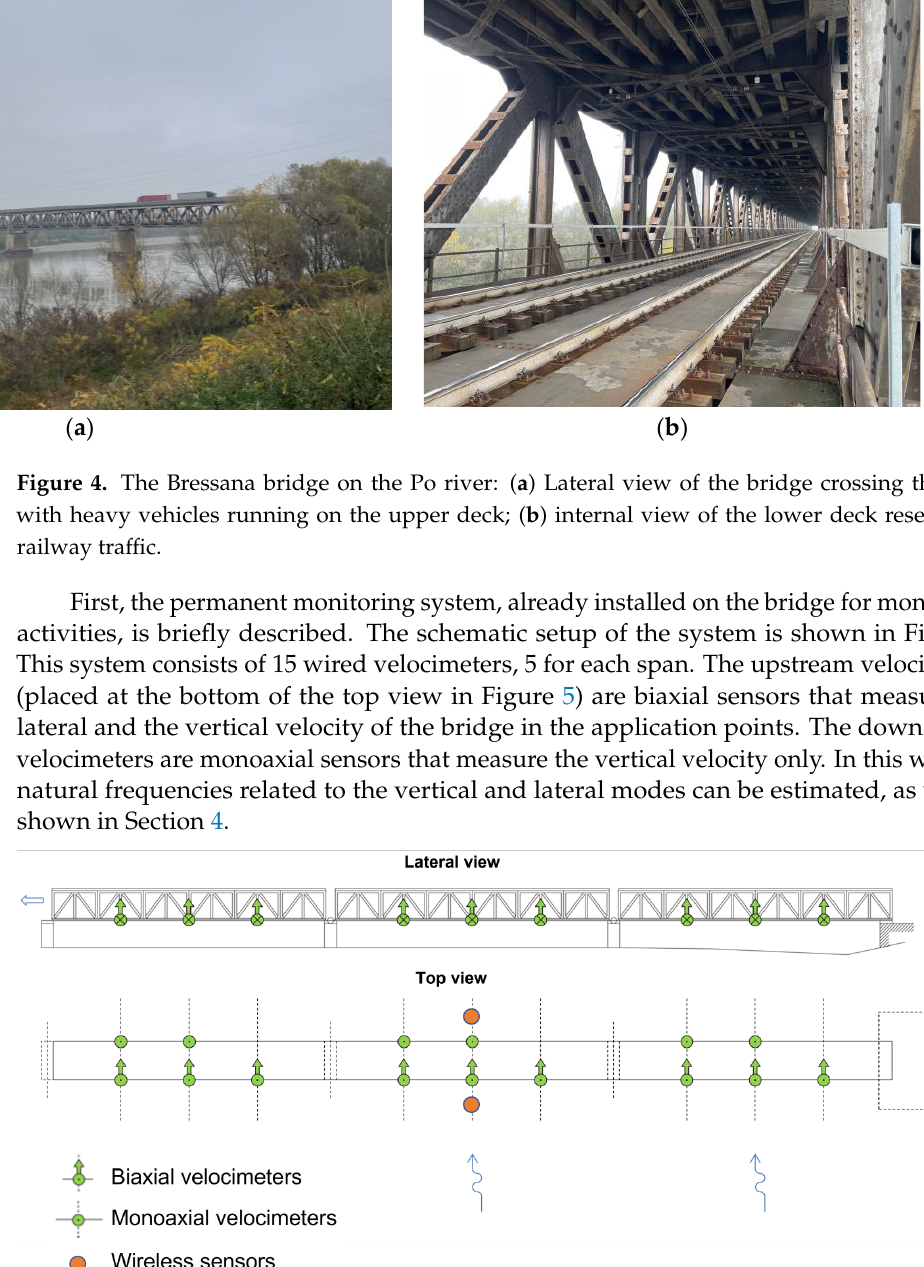
Figure 3. Schematization of the acquisition procedure.